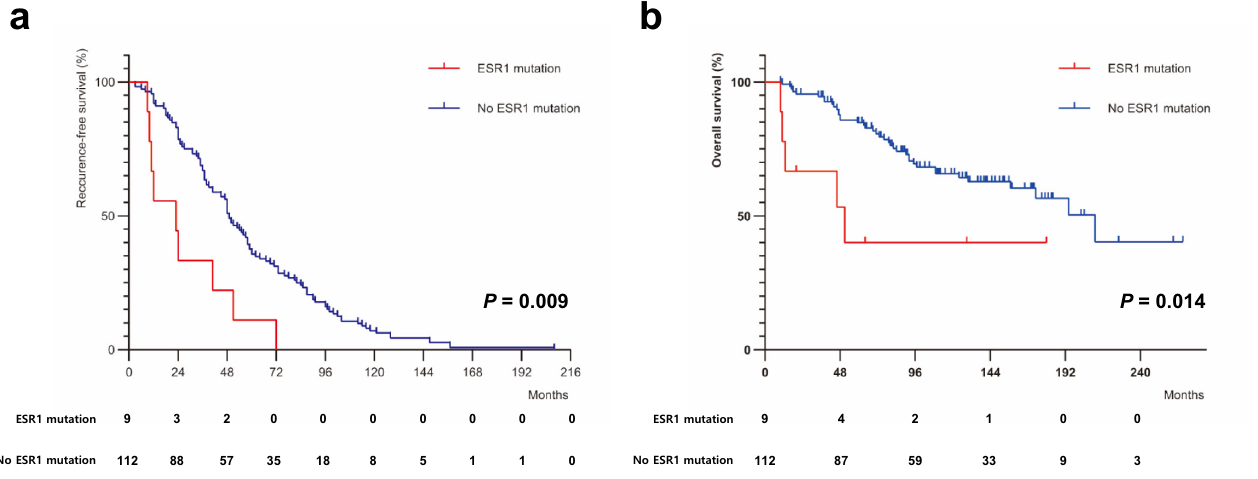
Fig. 3 Kaplan-Meier survival plots according to ESR1 mutation. a Recurrence-free interval. b Overall (25.0%) had secondary endocrine resistance (Fig. 4). None of the